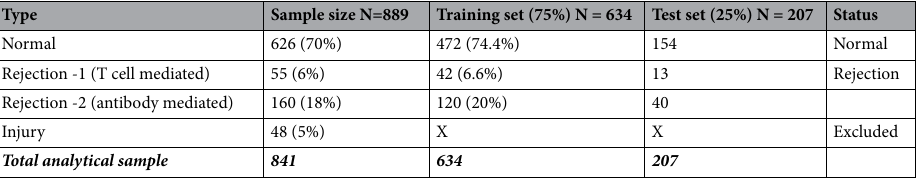
Table 1. Description of